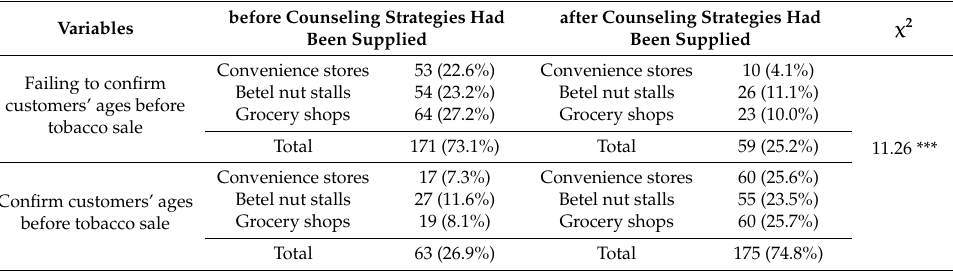
Table 2. Failing to confirm customer ages when selling tobacco products after counseling strategies had been supplied (n = 234).